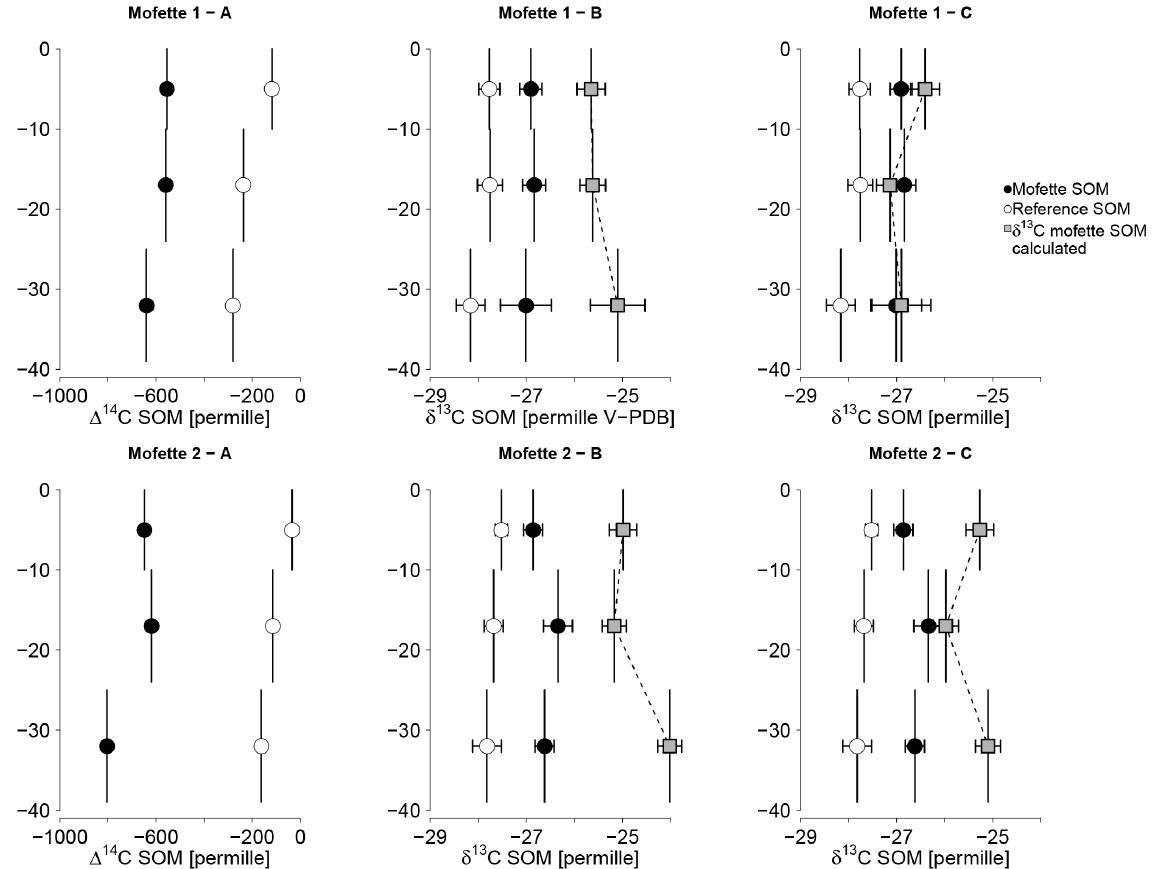
Figure 2. Depth profile of 14 C and 13 C signatures of SOM in mofette and reference soils. (a) Radiocarbon values in mofette soils are more depleted than reference soils, reflecting incorporation of geogenic CO 2 either by plants or by microorganisms. Error bars reflect analytical precision because only one homogenized sample was analyzed. (b) δ 13 C values in both mofettes are also shifted towards geogenic CO 2 , but to a smaller extent than radiocarbon values. Gray squares in δ 13 C depth profiles show values of δ 13 C in mofette SOM estimated using Eq. (9). Measured δ 13 C values are more depleted than estimated values at all depths. (c) Estimated δ 13 C values, assuming Eq. (9) but with (cid:49) 14 C values that have been corrected for radioactive decay assuming that SOM ages with depth in the same way as the reference soil. These estimated δ 13 C values agree with measured values below 20cm depth but remain depleted compared to what is expected from a pure plant SOM source in the top 10cm. This suggests that the observed depletion in the top 10cm of both mofette soils is caused by addition of 13 C depleted microbial carbon, derived from fixed CO 2 . In contrast, the mismatch between estimated and measured values below 20cm depth in (b) can be explained by radioactive